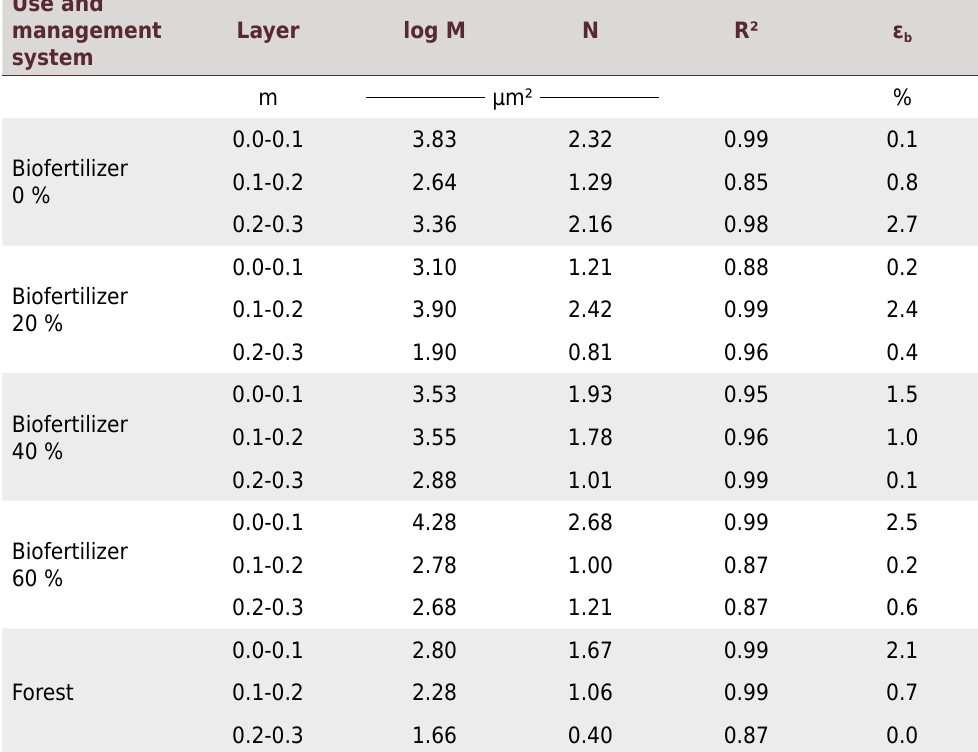
Table 4. Parameters of the regression equation, log K air = log M + N log ɛ air , and blocked porosity (ɛb) for areas under fig cultivation and secondary native forest, in the layers of 0.0-0.1 m, 0.1-0.2 m and 0.2-0.3